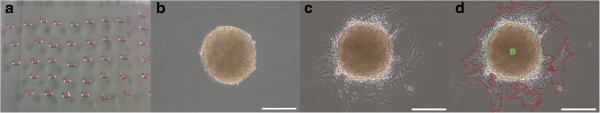
Migration assay. (a) Culture of MSCs using a spheroid system. (b) Attachment of spheroid 4 hours after seeding (c) and MSC migration 24 hours after spheroid seeding. (d) At the 24 hour time point, the spheroid size was measured (area B) and subtracted from the area of the maximum range of migrated MSCs (area A). Scale bar = 200 μm. (MSCs: multipotent mesenchymal stromal cells).